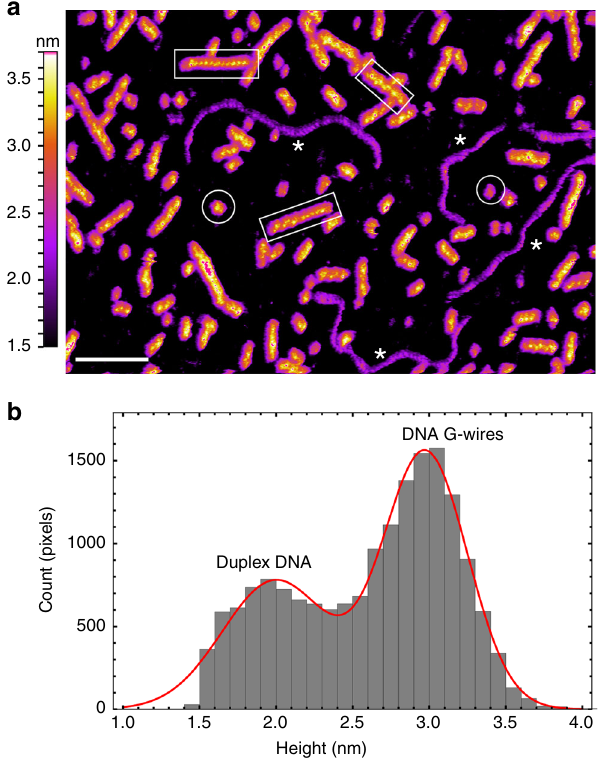
Fig. 1 Visualization of DNA G-wires in aqueous solution. a AFM height image of G-wires and duplex DNA. Selected duplex DNA are indicated by asterisks (*). Selected G-wires are boxed. Objects with length < 7 nm and height > 2 nm were identi fi ed as isolated G-quadruplex blobs (circled). The length scale (white bar) is 30 nm. b Histogram of pixel height taken along the central spline of duplex DNA and G-wires with a length > 10 nm from the above AFM image (full